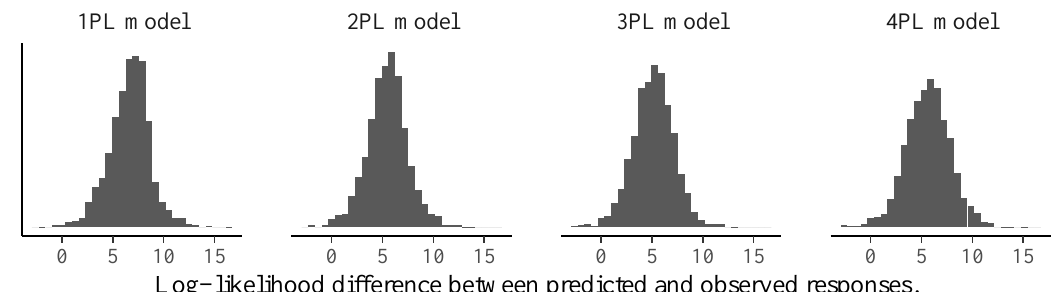
Figure 8. Person-specific posterior distributions of log-likelihood differences between predicted and observed responses for the 192nd person and different models estimated via MCMC-H. If the majority of the posterior distribution is above zero, this indicates model misfit for the given